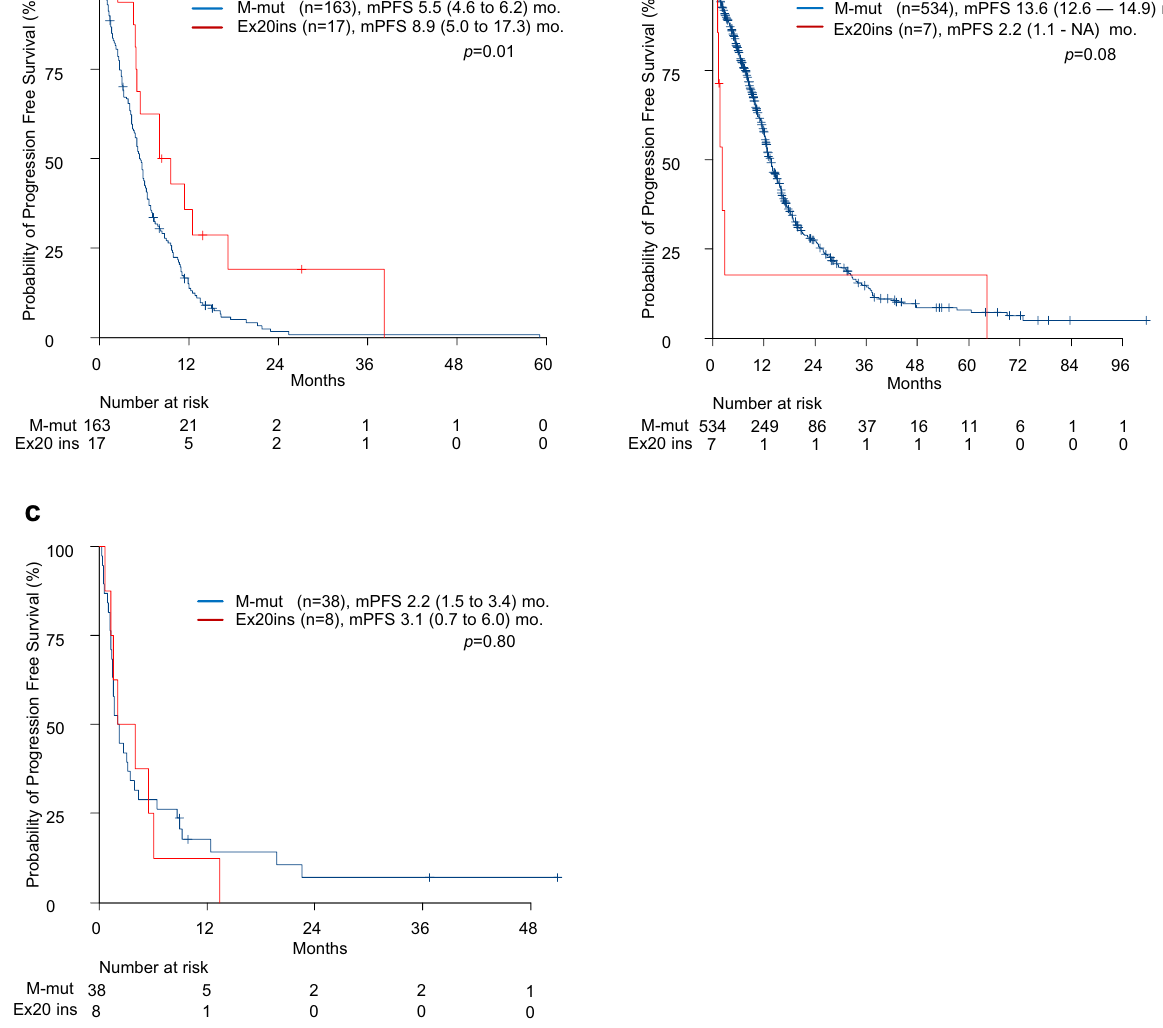
Figure 1. Median progression free survival after ( a ) platinum doublet chemotherapy, ( b ) EGFR-TKIs, and ( c ) anti-PD-1 antibody treatment in patients with EGFR exon 20 insertions and major mutations (L858R and exon 19